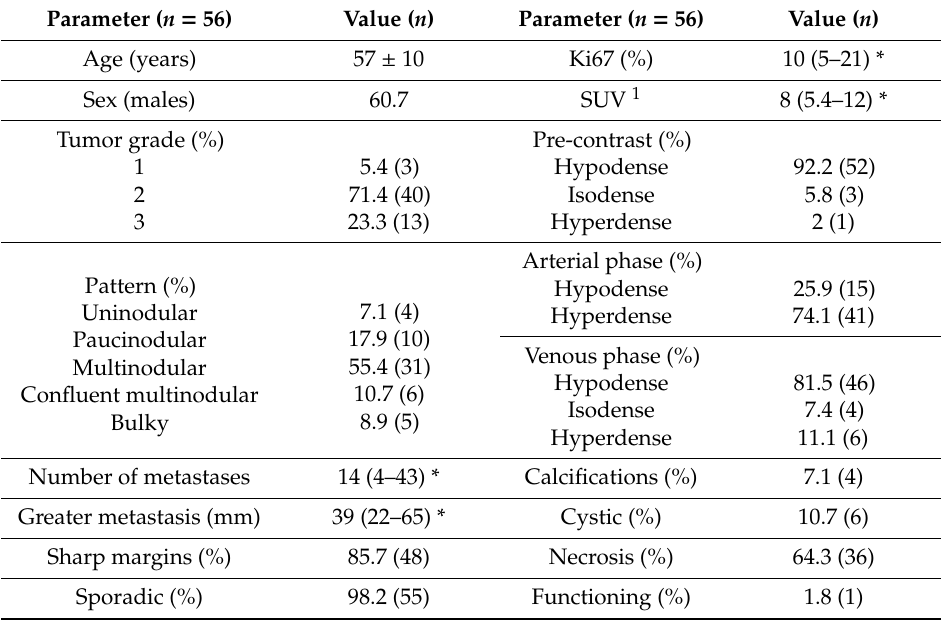
Table 1. Population characteristics and qualitative descriptors of liver tumor